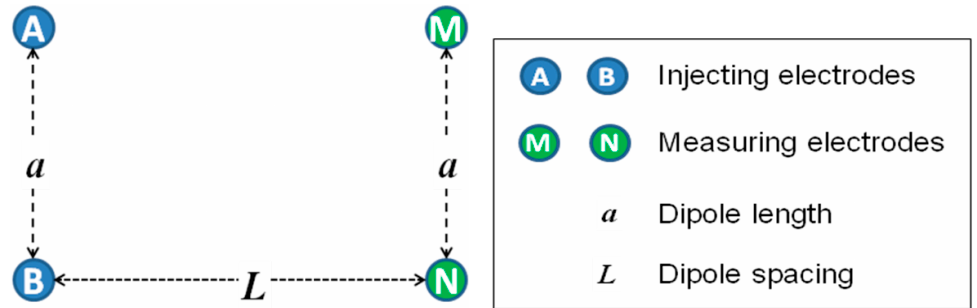
Figure 1. Equatorial dipole-dipole electrode configuration.